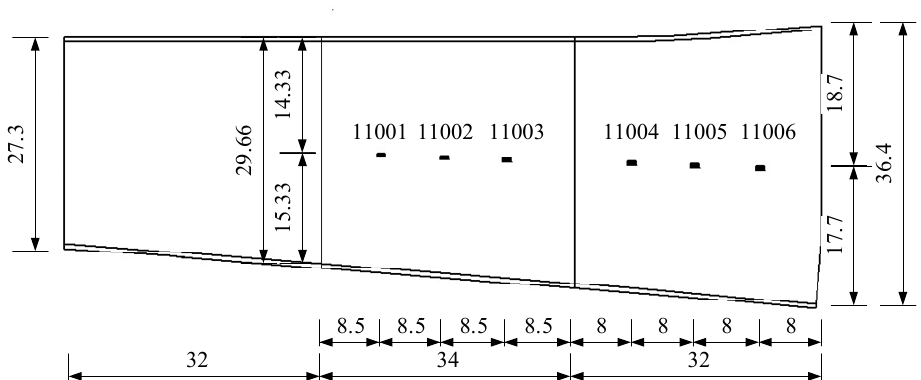
Figure 13. Photograph of an actual bridge.